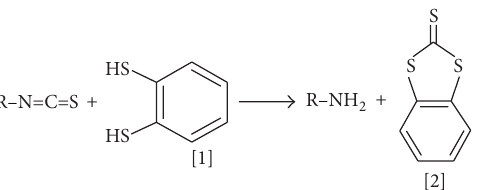
Figure 1: Cyclocondensation reaction of ITCs with 1,2-benzenod- ithiole [1] , to form 1,3-benzodithiol-2-thione [2] .